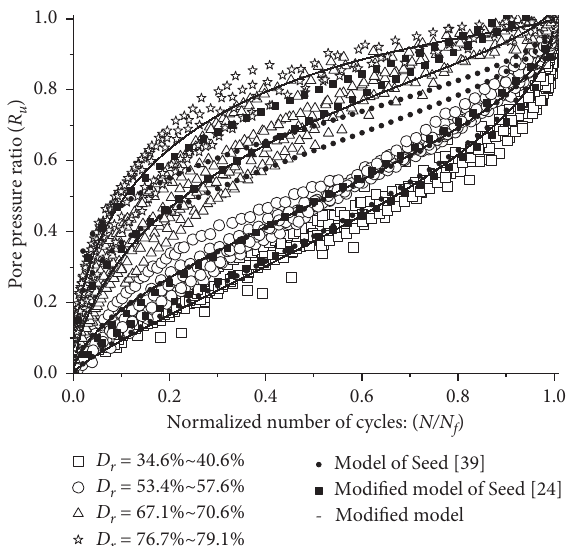
Figure 14: Comparison of pore pressure growth curves of different types of calcareous sand [19, 24].